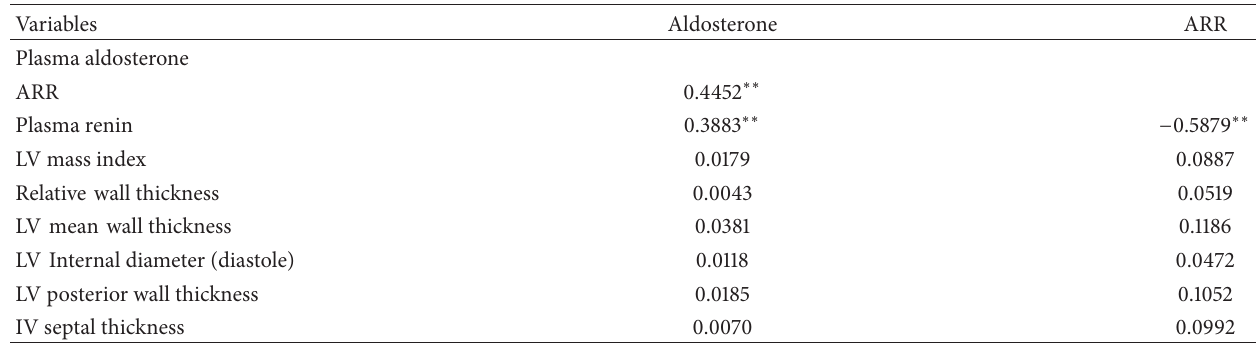
Table 4: Correlation coefficients between aldosterone levels, aldosterone-to-renin ratio levels, and echocardiographic parameters of left ventricular